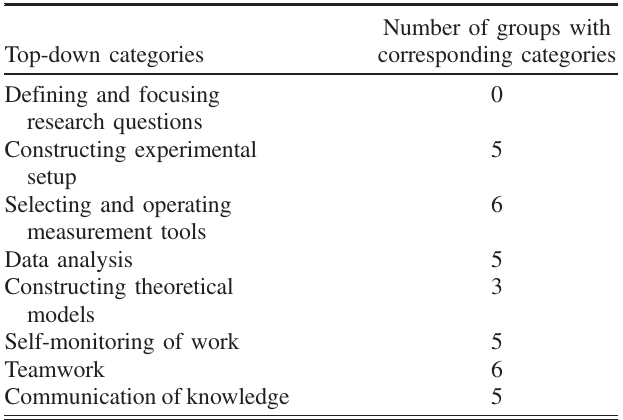
TABLE I. Correspondence between top-down and student- made categories ( N ¼ 8